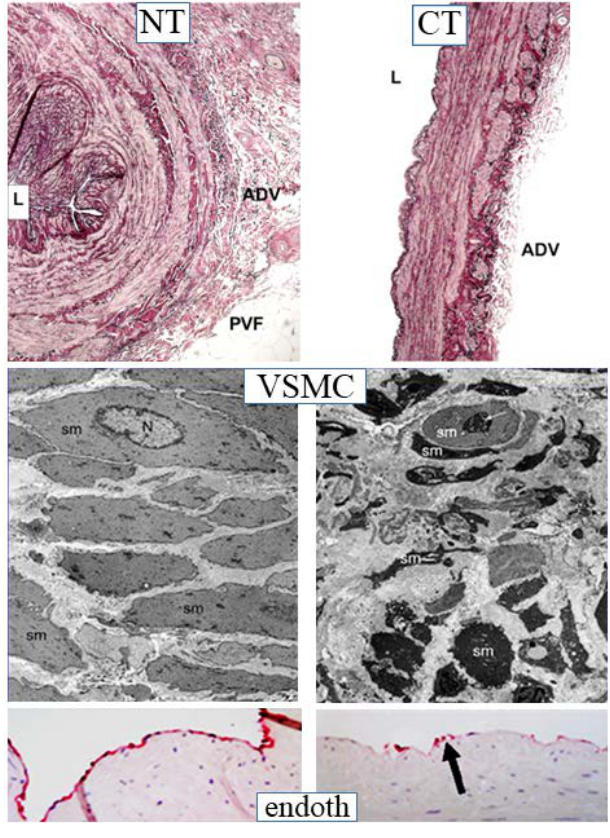
Fig. 3 - No-touch (NT) versus conventional (CT) saphenous vein (SV); vascular smooth muscle and endothelial cells. Top left panel: Part of a transverse section of NT SV where the lumen (L) is folded, the adventitia (ADV) and perivascular fat (PVF) remain intact, and the vessel wall is thick. Top right panel: In the CT SV, the PVF is removed, and the ADV is partially removed and/or damaged. Middle left panel: A representative example of a transmission electron micrograph showing the ultrastructure of vascular smooth muscle vessel cells (VSMC) within the media of NT SV that are of regular size and uniform shape. Middle right panel: VSMCs in the media of CT SV exhibit polymorphism and are ovoid, elongated, or multishaped. (Both from Ahmed et al. [7] , 2004). Lower left panel: The luminal endothelium (red staining) of NT SV is continuous. Lower right panel: The endothelium in CT SV is damaged with only few cells remaining intact (arrow). N=nucleus; sm=smooth muscle.